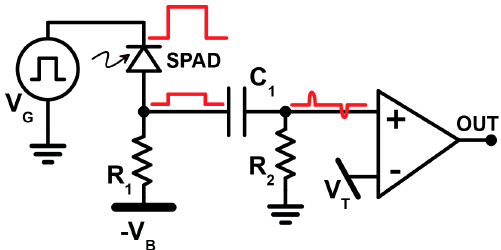
Figure 7. Basic electrical circuit of a time-gated (TG) single-photon avalanche diodes (SPADs) [31]. The gate pulse is provided by the voltage pulse generator (V G ). The SPAD is reversely biased at a voltage-V B . The comparator switches its output (OUT) when the voltage at the positive input exceeds a threshold voltage V T . Supposing that no avalanche occurs during the gate-ON time, the positive input of the comparator is reached by 2 voltage spikes due to the application of fast voltage transition at the cathode side of the SPAD, which can trigger the comparator if exceeding V T .